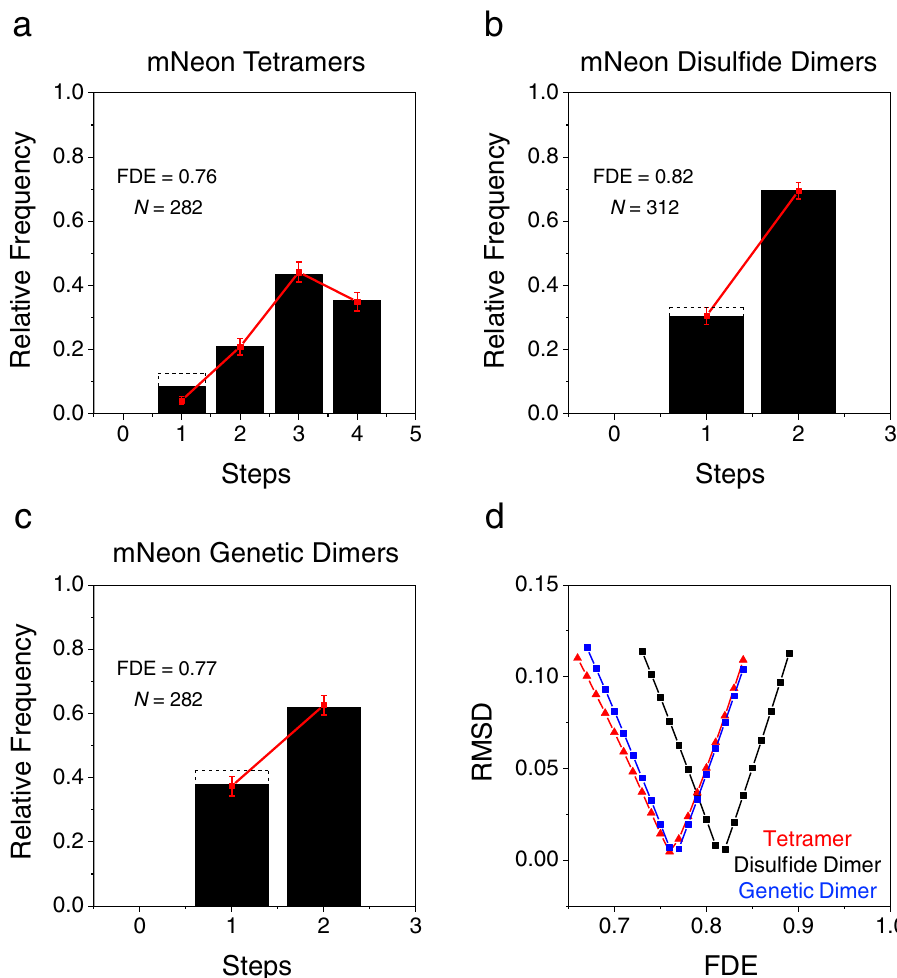
Fig. 7 Photobleaching step histograms for mNeon tetramers and dimers. a Photobleaching step histogram for mNeon tetramers (disul fi de dimers of 2xmNeonC). The data (black) were fi t assuming that the fl uorescently active mNeon proteins were binomially distributed within the individual tetramers, yielding a best fi t (red) fl uorescence detection ef fi ciency (FDE) of 0.76. The single step data were ignored for the fi t shown, acknowledging the known presence of surface contaminants. The corrected single-step data (solid; original data shown as dashed box) obtained by subtracting the estimated number of contaminants (~1.9 spots/ fi eld; see Supplementary Fig. 3) agree better with the prediction from the fi t. b Photobleaching step histogram for disul fi de dimers of mNeonC. Assuming a binomial distribution of the fl uorescently active mNeon proteins, the corrected data (solid black) predict an FDE ≈ 0.82. The correction here (original data shown as dashed box) is substantially less than in a since the dimer single step data were a larger fraction of the total and the dimer spots were somewhat more densely distributed on the surface than the tetramer spots. c Photobleaching step histogram for mNeon genetic dimers. The FDE ≈ 0.77 obtained here is lower than that obtained for the disul fi de dimers ( b ) but similar to that of the tetramers ( a ), which were generated from genetic dimers. a – c Error bars are standard deviations (SDs) obtained from 5000 simulated distributions of N values each, where N is the number of experimental measurements from one protein preparation, as indicated. d The optimal FDE. The RMSDs for different FDE values were calculated for the data in a – c , as indicated. Tetramer fi ts were to step bins 2 – 4; dimer fi ts were to the corrected